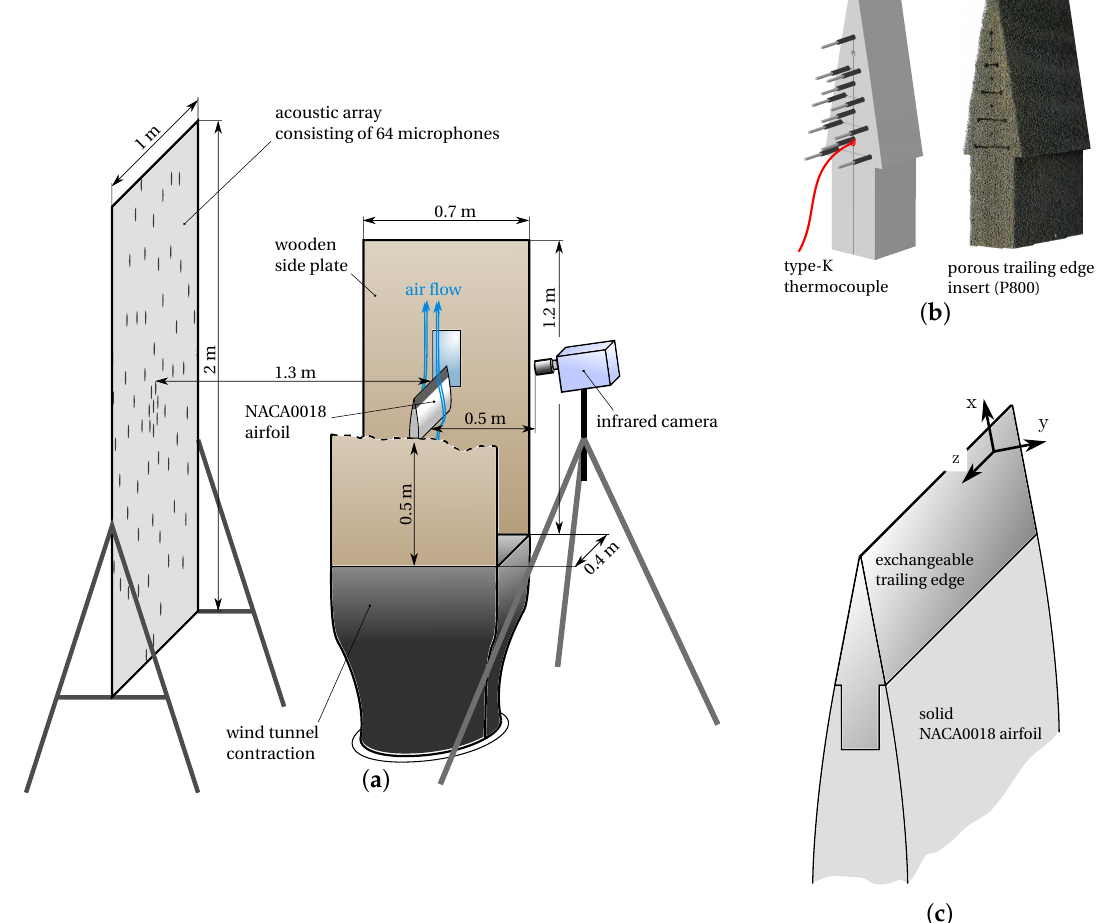
Figure 2. Aeroacoustic measurement setup in the vertical, anechoic wind tunnel of TU Delft ( a ). The airfoil can be equipped with exchangeable trailing edge inserts ( c ) and heating of the porous metal foam is achieved by means of electrical heating wires ( b